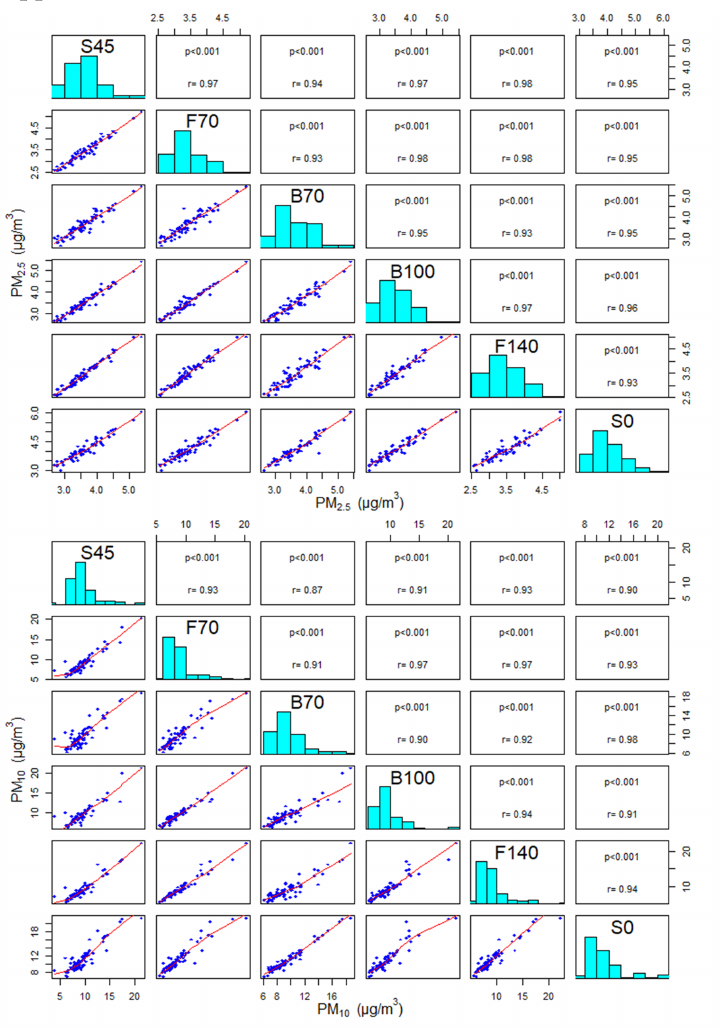
Figure A1. Correlation matrix of aerosol monitors during the co-location